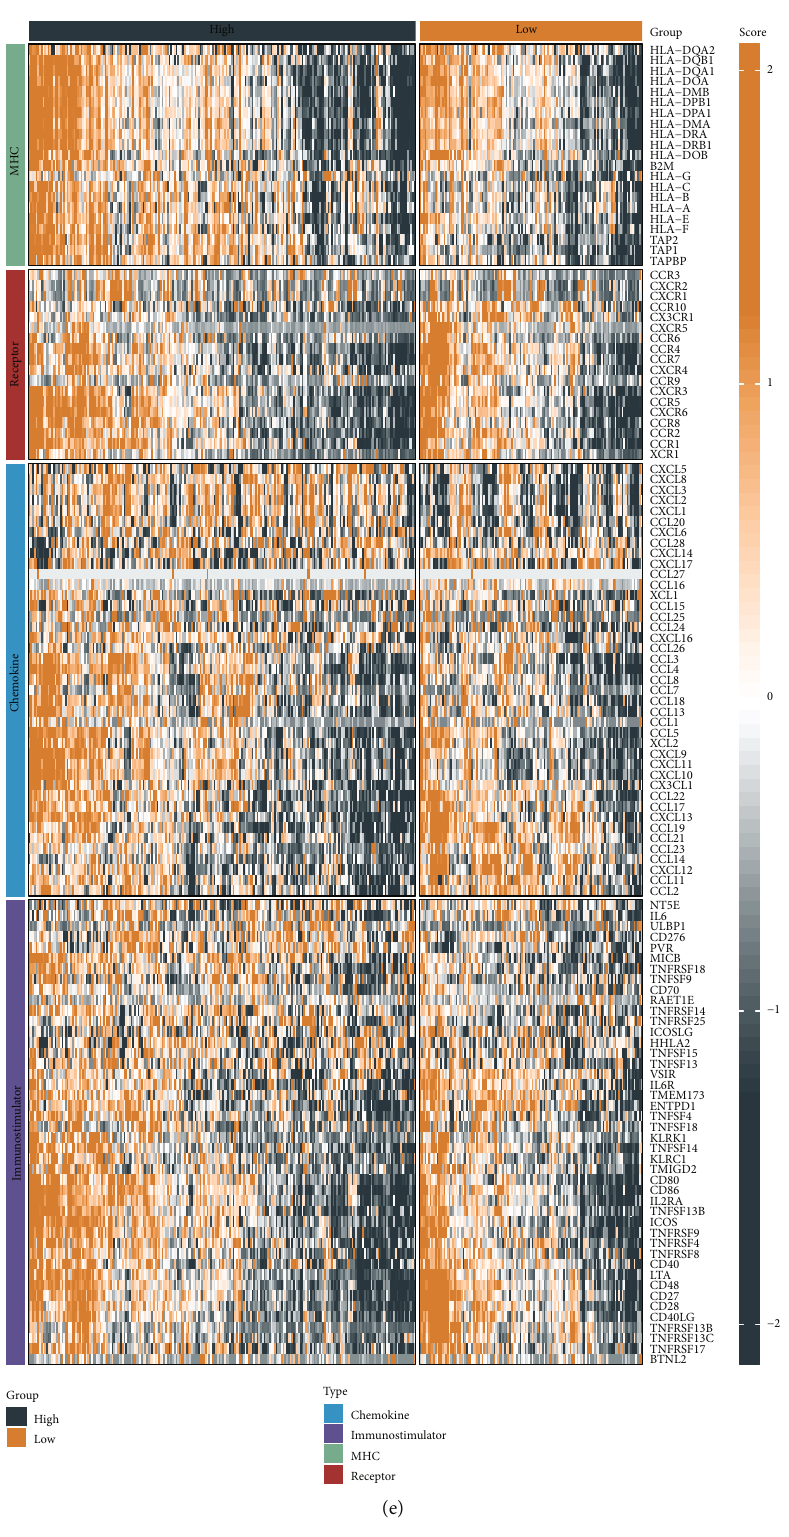
Figure 4: Comparative analysis for immune pro fi les of NCAPG subgroups in STAD. (a – d) Expression di ff erences of di ff erent types of genes (chemokines, receptors, MHC, and immunostimulants) between NCAPG subgroups in STAD; (e) heat map of di ff erential expression among gene types (chemokines, receptors, MHC, and immunostimulants) in STAD ( ∗ , P < 0 : 05 ; ∗∗ , P < 0 : 01 ; ∗∗∗ , P < 0 : 001 ; ∗∗∗∗ , P < 0 : 0001 ; ns, P > 0 : 05